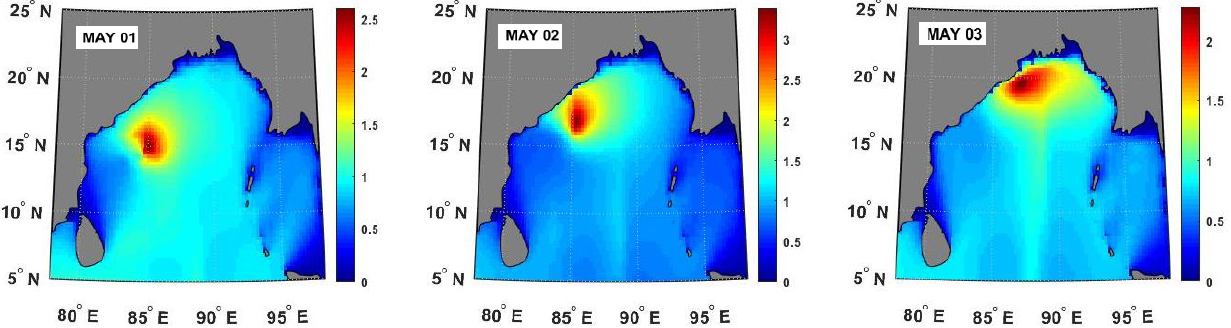
Figure 11. Computed SWH (m) for FANI cyclone from 1 to 3 May 2019 using SCATSAT-1 daily 25 km wind data.